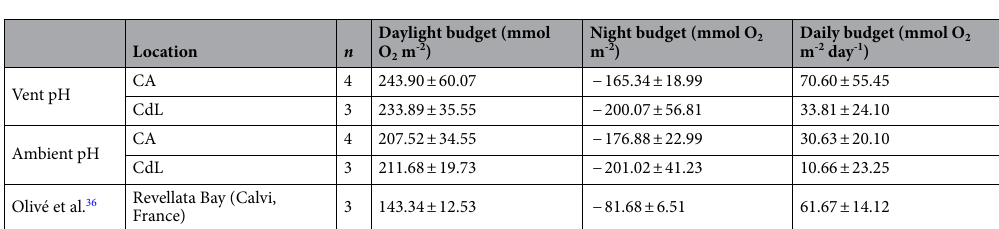
Table 2. Daily metabolic budgets (mean ± SE) of P. oceanica at vent and ambient pH sites at Castello Aragonese (CA) and Chiane del Lume (CdL). Daylight budget was calculated from net community production (NCP) and night budget from community respiration (CR), assuming an 11:13 light: dark cycle. Negative values mean a net consumption of O 2 . The daily budget was calculated as the sum of daylight and night budget. The budgets calculated by Olivé et al. (2016) after 1.5-2 h incubation time were added for comparison.